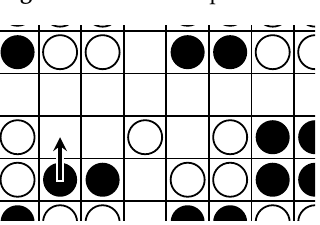
Figure 16. WHITE captures.